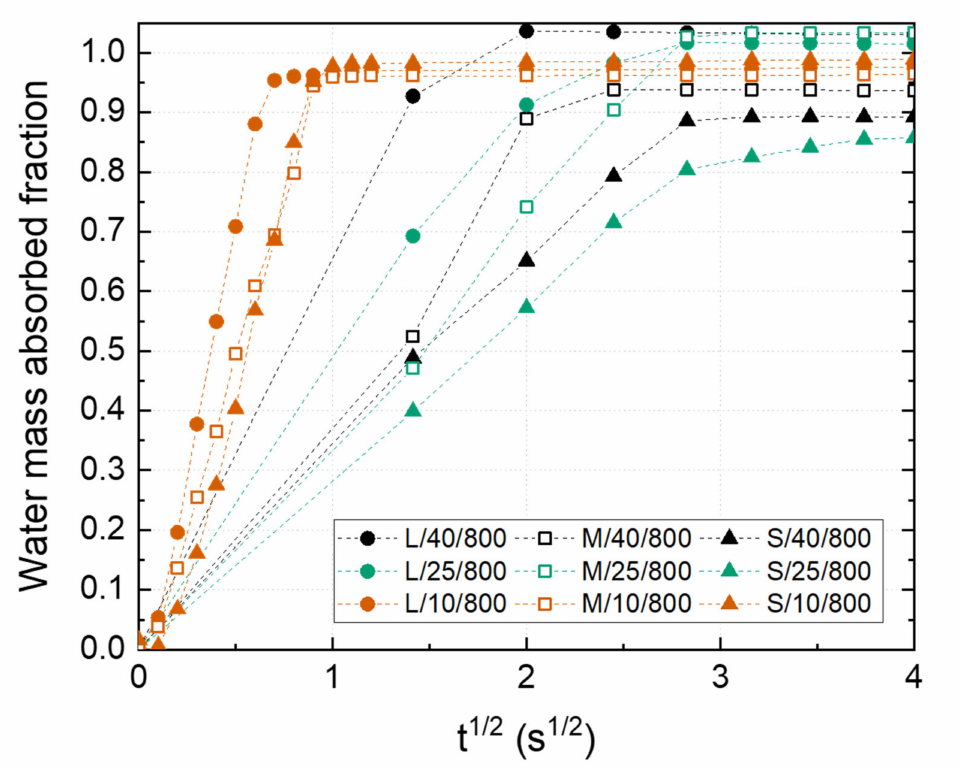
Figure 6. Water mass absorbed fraction of the Ni wicks sintered at 800 ◦ C as a function of the particle size range (S, M, L) and the freezing temperature (10, 25, and 40 ◦